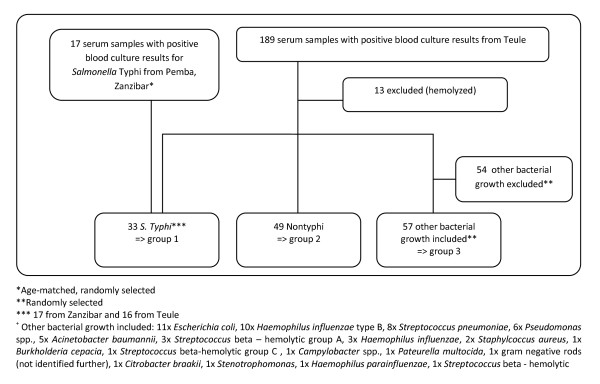
Specimen assembly.